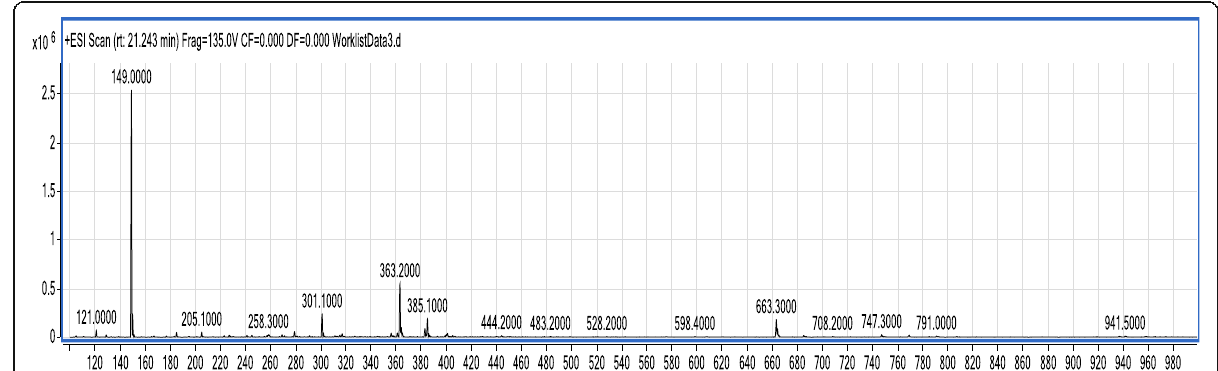
Fig. 8 Mass chart shows the fragment ions of 6-(4 ′ -hydroxy-2 ′ -methyl phenoxy)-( − )-